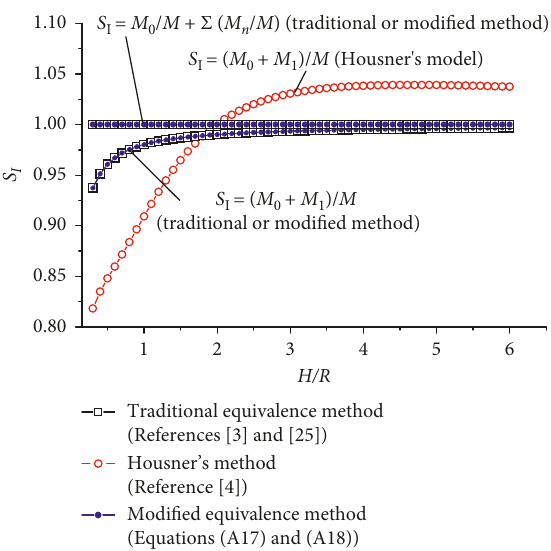
Figure 10: Condition of mass conservation (cylindrical tank). R / g vs. 1